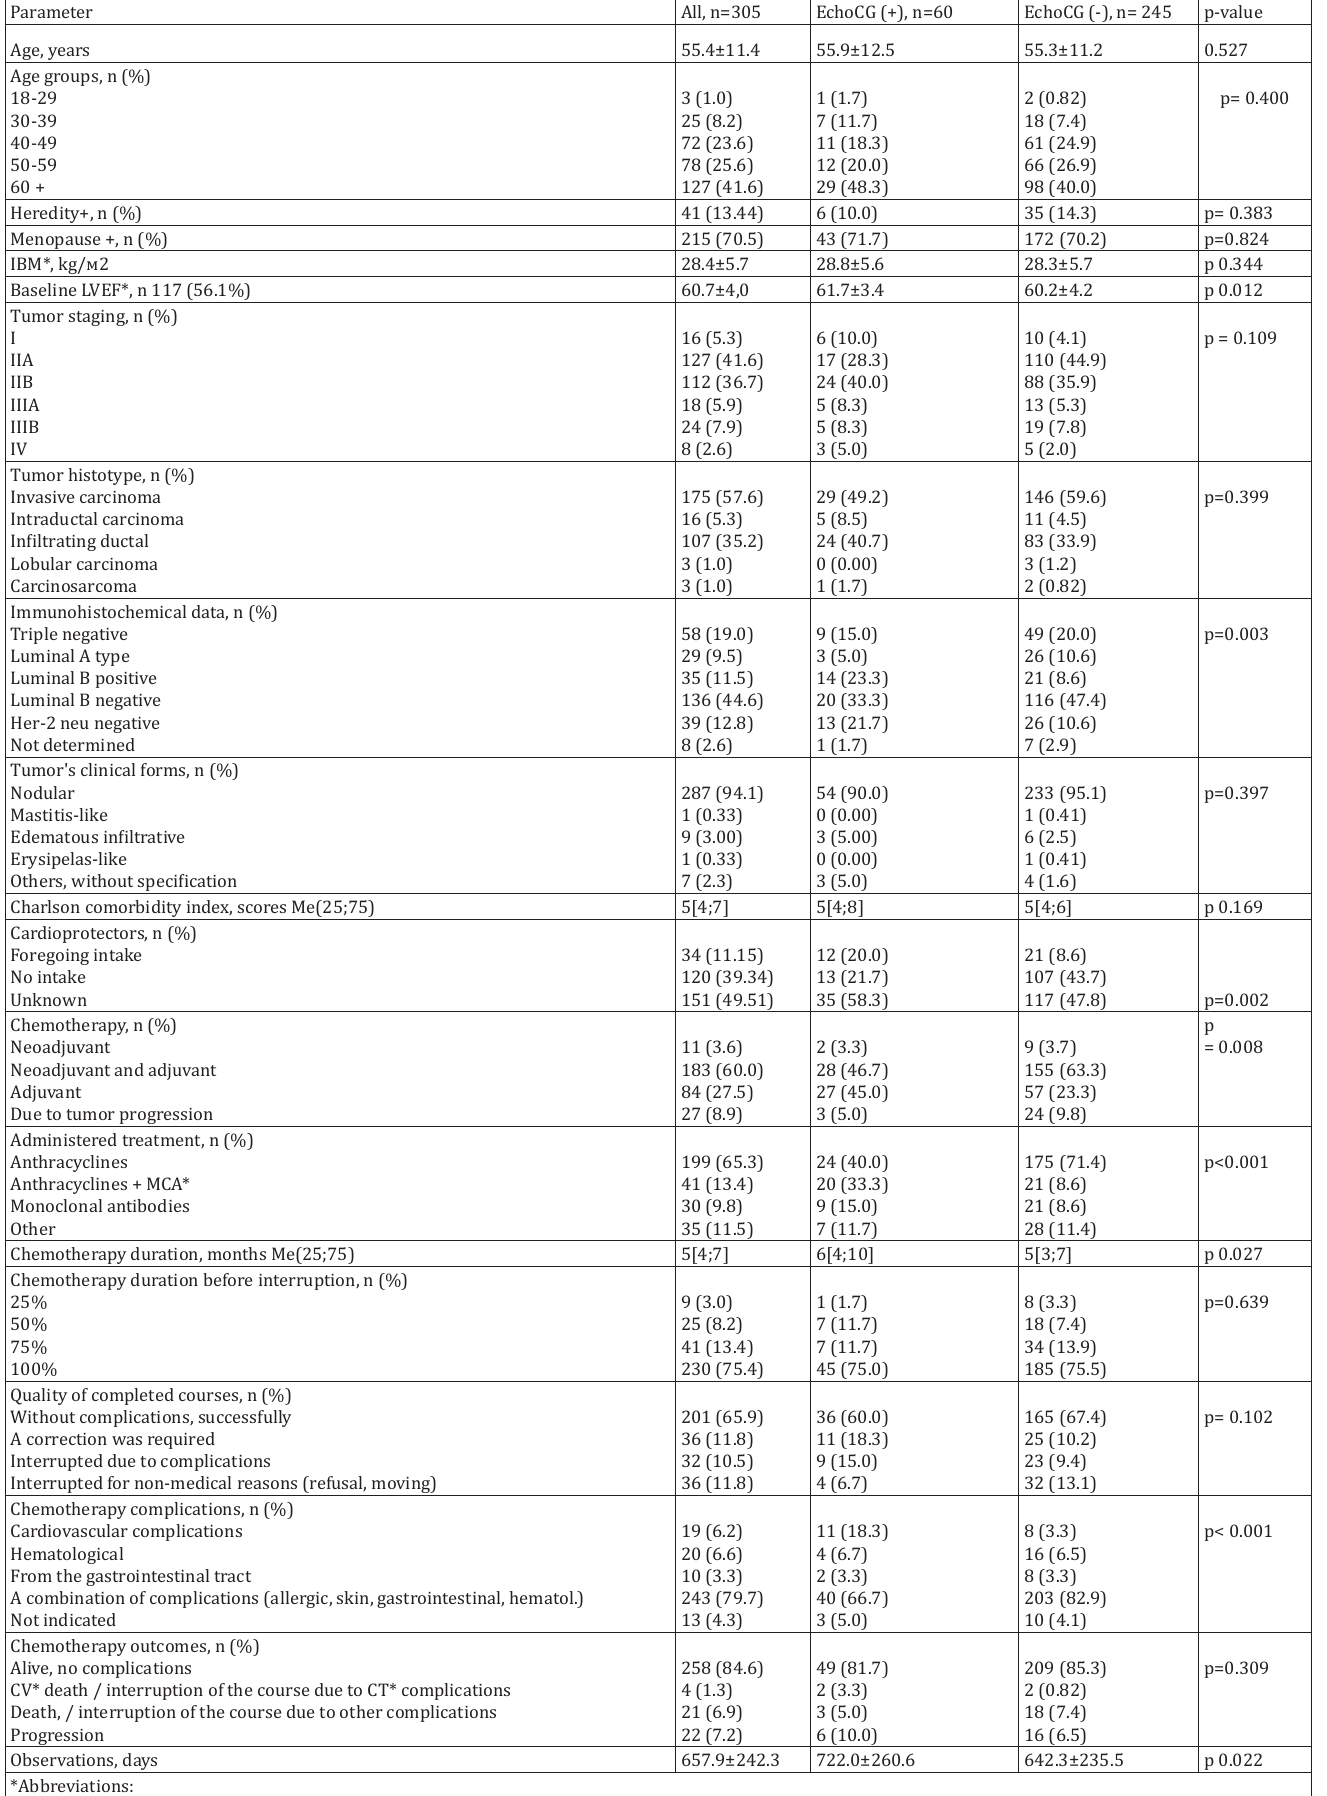
Descriptive statistics of patients in the context of EchoCG monitoring, characteristics of the tumor process, and